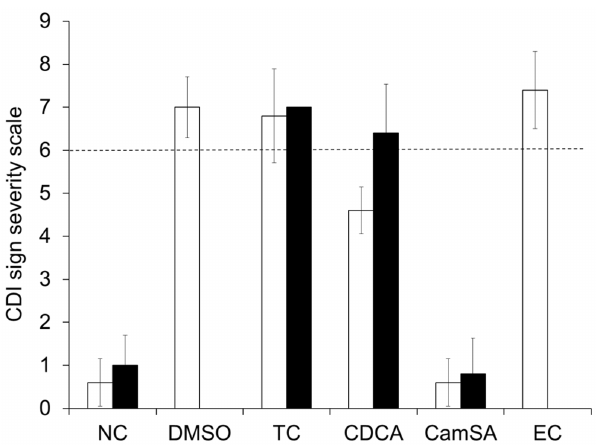
Figure 1. CamSA protects mice from CDI. Comparison of CDI sign severity after 48 hours (white bars) and 72 hours (black bars) of animals challenged with C. difficile spores and treated with DMSO, 300 mg/kg taurocholate (TC), 50 mg/kg chenodeoxycholate (CDCA), 50 mg/kg CamSA, or 300 mg/kg ethyl cholate (EC). Non-challenged (NC) animals were used as controls. Clinical endpoint was set as . 6 in the CDI sign severity scale (dashed line). None of the animals in the DMSO and EC groups survived to 72 hours post-challenged. Standard deviations represent at least five independent measures.